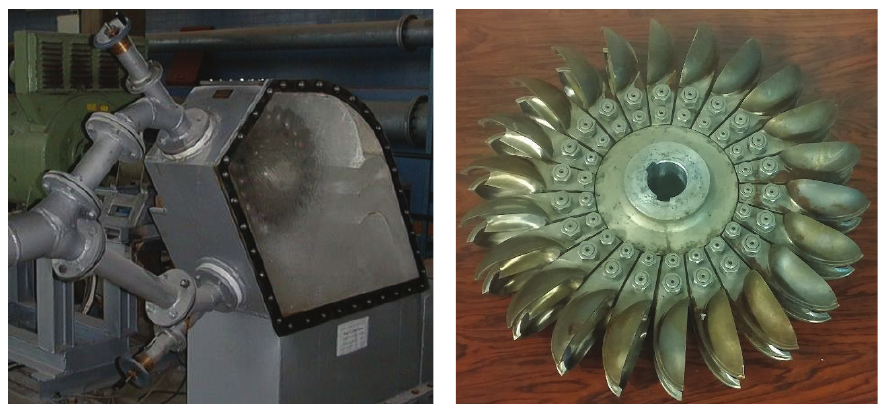
Figure 3: Pelton model turbine and its runner installed at the